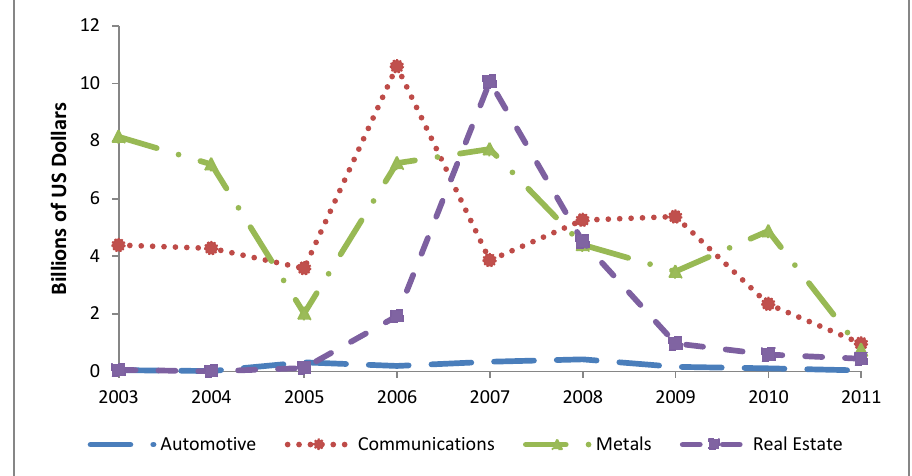
FIGURE 2: M&A FDI inflows – Africa Source: Zephyr Database